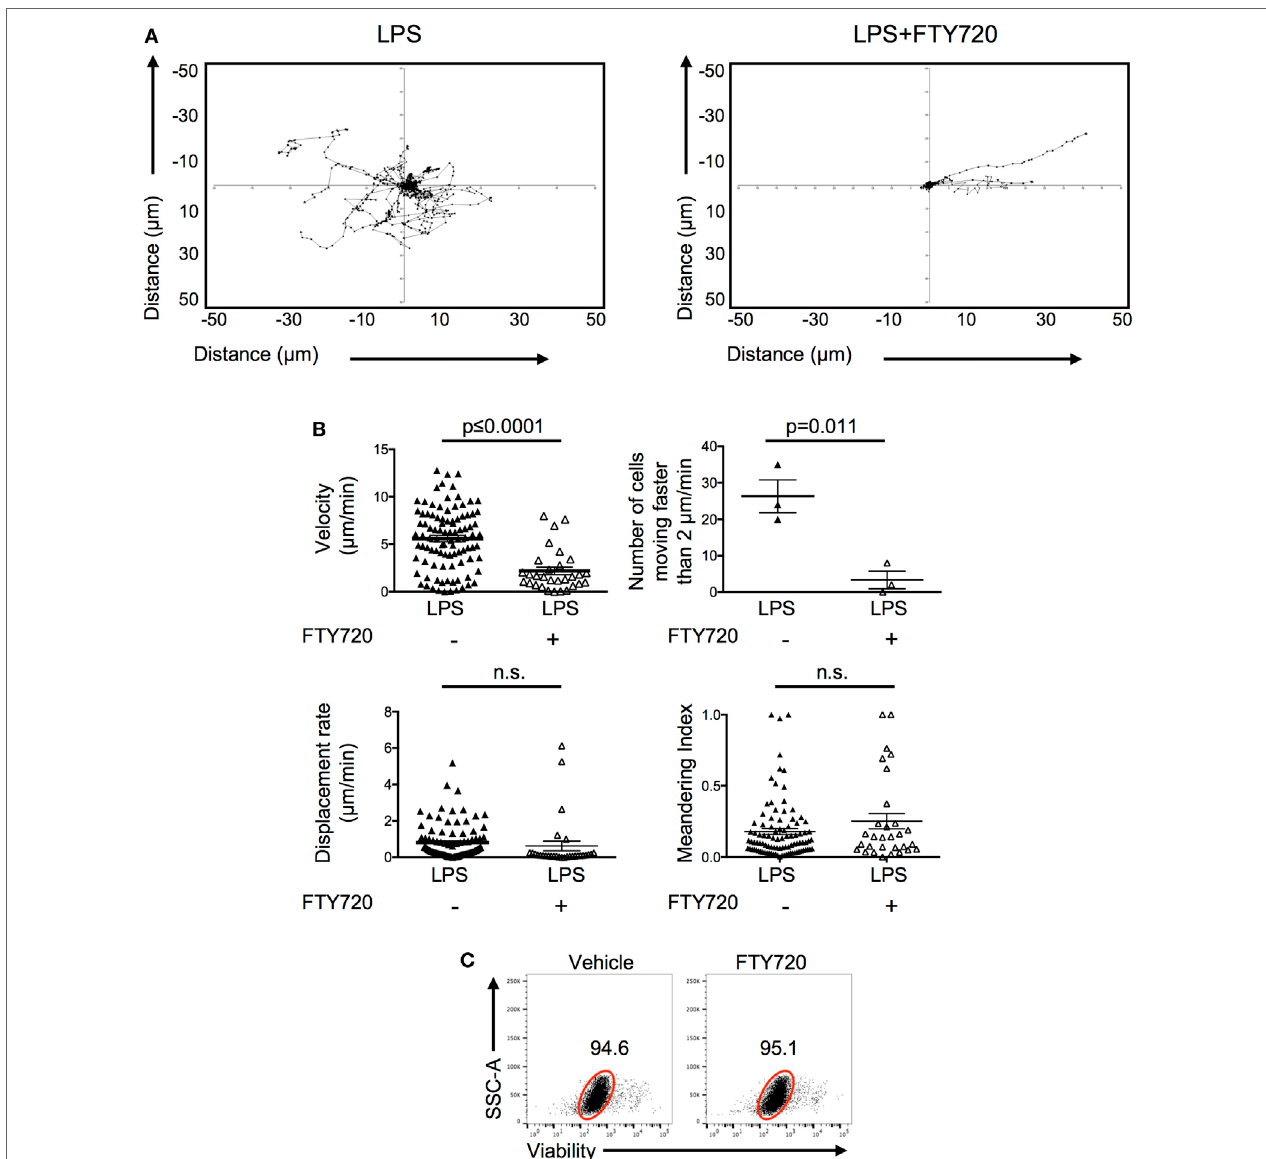
FigUre 7 | Signals through S1P1 receptor cause increased CD4 T cell movement in inflamed tissues. Activated OT-II T cells were treated with vehicle or FTY720 before transfer into the ear pinnae of mice injected with PBS or lipopolysaccharide (LPS) 24 h earlier. After a further 24 h, mice were anesthetized and OT-II T cells imaged by multiphoton microscopy. Data show tracks of individual cells from the ear of one mouse per treatment (a) or velocity, number of cells per mouse moving above 2 μ m/min, displacement rate and meandering index. For velocity, displacement rate, and meandering index, each symbol represents a cell, and the horizontal line indicates the mean of the group. For numbers of cells moving above 2 μ m/min, each symbol represents a mouse, and the horizontal line shows the mean of the group; error bars are SEM. Data are combined from three animals per group (B) . In panel (c) , activated OT-II T cells treated with vehicle or FTY720 were rested overnight in vitro and viability determine by exclusion of viability dye. Cells are gated on activated cells, and data are representative of three